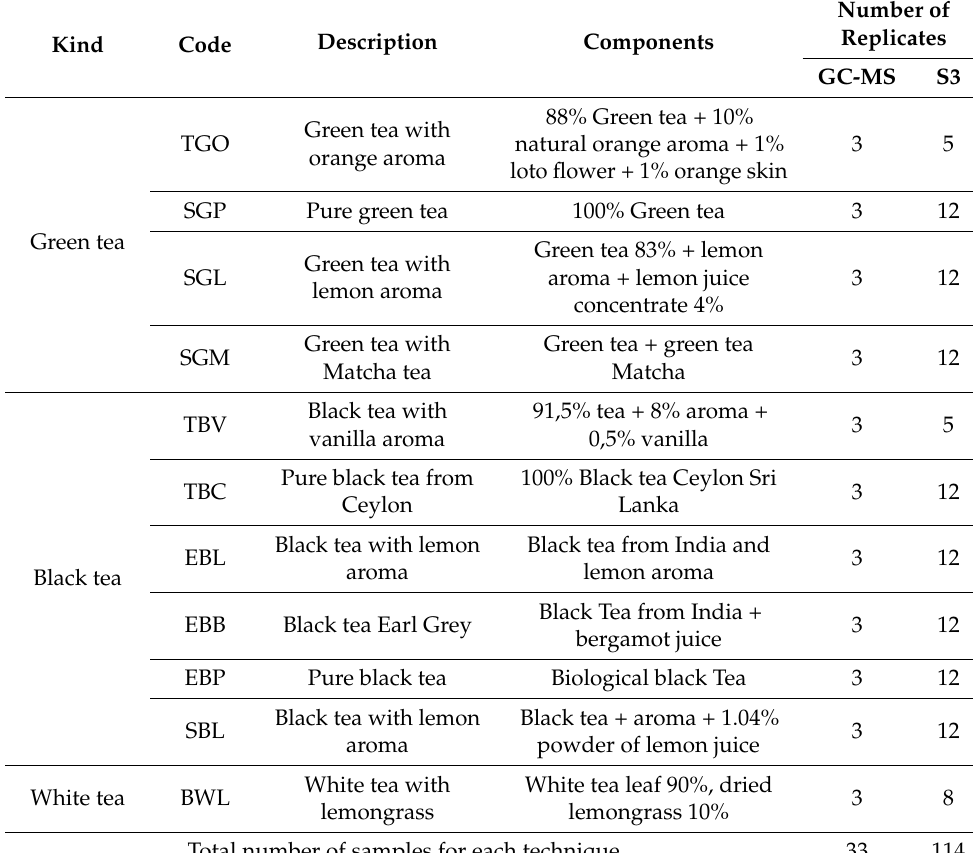
Table 1. Samples